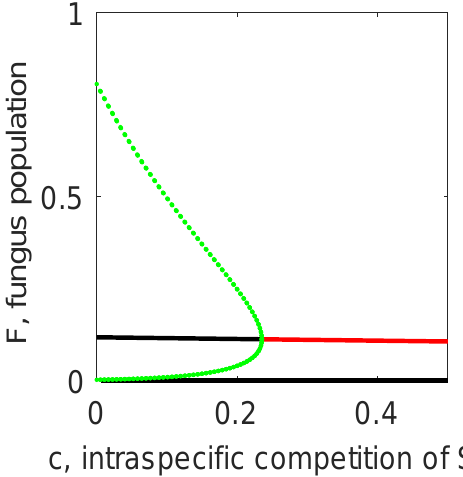
Fig. 6 Zoomed portion of the Figure